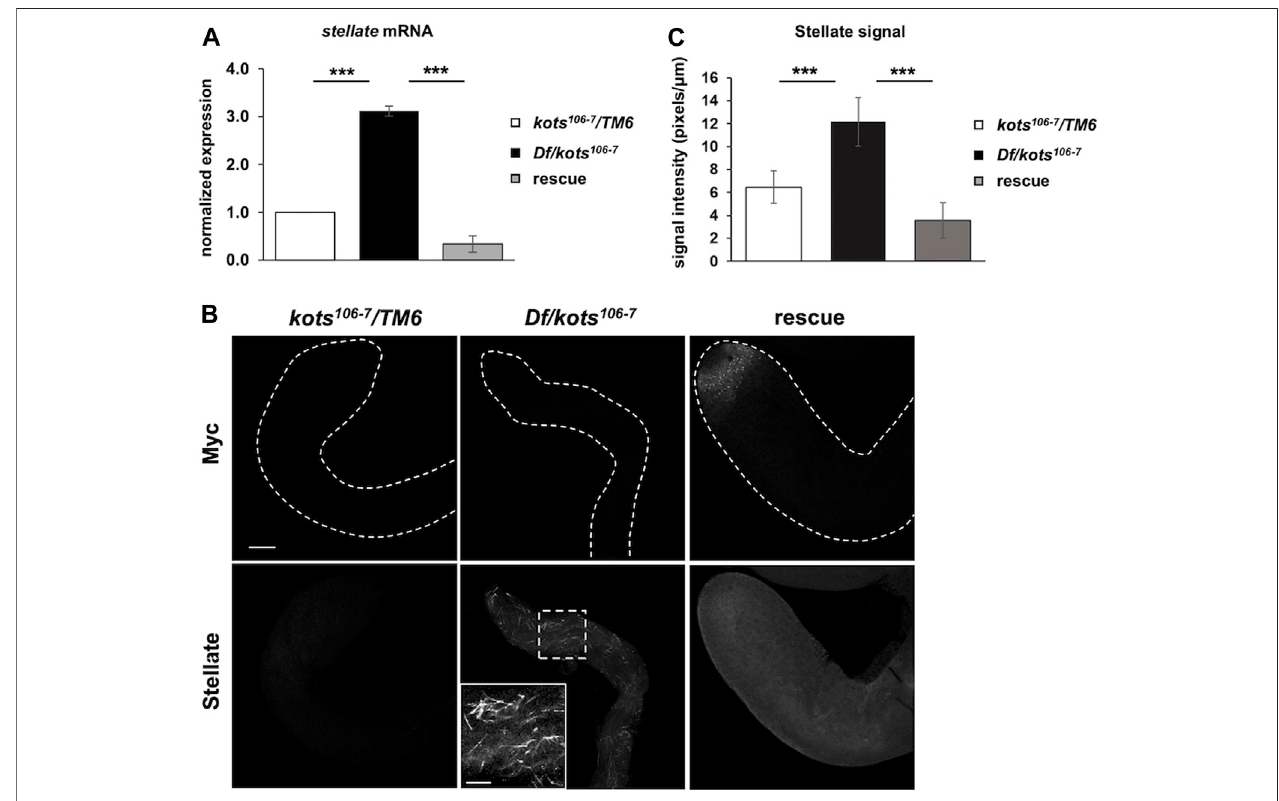
FIGURE 2 | Loss of kots results in upregulation of stellate in testes. (A) Derepression of stellate (ste) in loss-of-function kots testes and re-repression in fl ies expressing Kots-Myc in kots mutant background ( n = 3, t -test, p -value < 0.005, error bars indicate s.d.). kots heterozygous testes were used as the control. (B) Robust upregulation of stellate (Ste) protein in kots mutant testes and re-repressionupon expression ofUASp -kots-Myc in testicular germlinecells bythe bam-Gal4 driver. Inset shows a magni fi ed image of Ste protein in mutant testes. kots heterozygous testes were used as the control. All scale bars are 20 μ m. (C) Quanti fi cation of Ste signal intensity in loss-of-function kots testes. Signal intensities were measured for independent regions ( n = 3) from each sample. The average signal intensities of Ste were normalized against the Myc signal. Increment of the Ste signal was observed in mutant testes compared to the control and was re-repressed in the rescue ( t -test, p -value < 0.05, error bars indicate